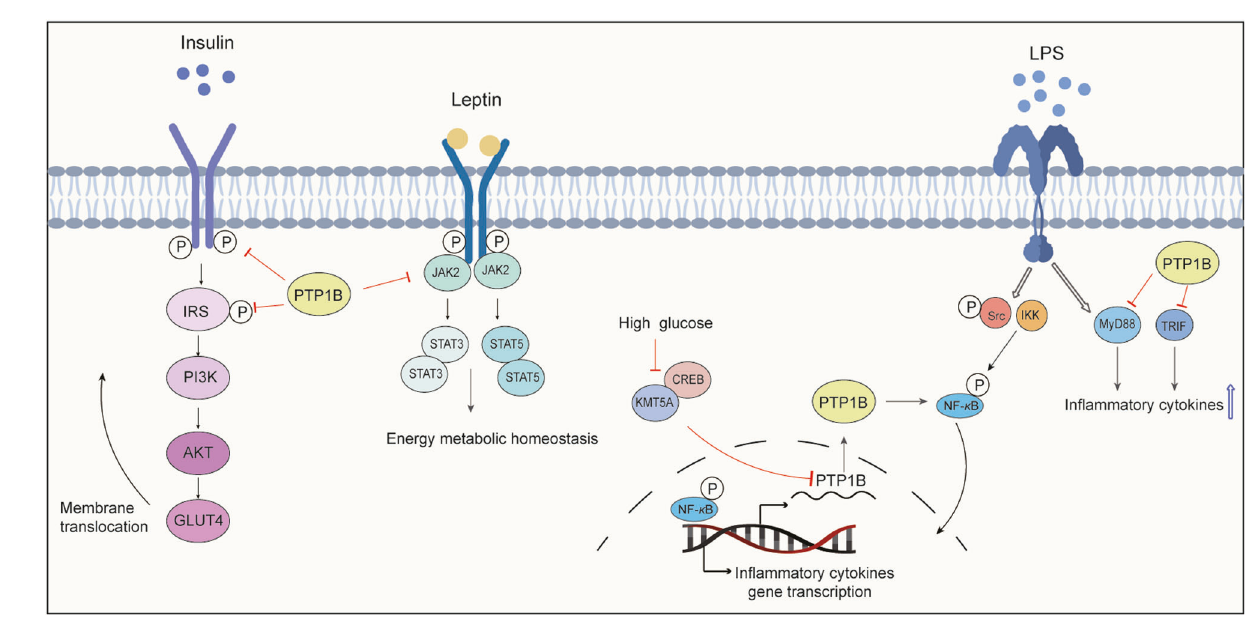
Fig. 8 The regulated signaling pathways of PTP1B in in fl ammatory diseases. The role of PTP1B in insulin signaling, leptin signaling, and LPS- TLR-mediated in fl ammatory signaling in diabetes, obesity, and other in fl ammatory diseases. PTP1B inhibits the phosphorylation of the insulin receptor and insulin receptor substrate and their downstream PI3K/AKT/GLUT4 signaling, thereby preventing the translocation of GLUT4 to the membrane to transport glucose. PTP1B also inhibits JAK2 phosphorylation and attenuates the leptin JAK2/STAT signaling pathway to affect metabolic energy homeostasis. The CREB/KMT5A complex regulates PTP1B to modulate high glucose-induced endothelial in fl ammatory factor levels in diabetic nephropathy. PTP1B also acts as a negative regulator of TLR signaling via the suppression of both MyD88- and TRIF-dependent production of proin fl ammatory cytokines in macrophages stimulated by